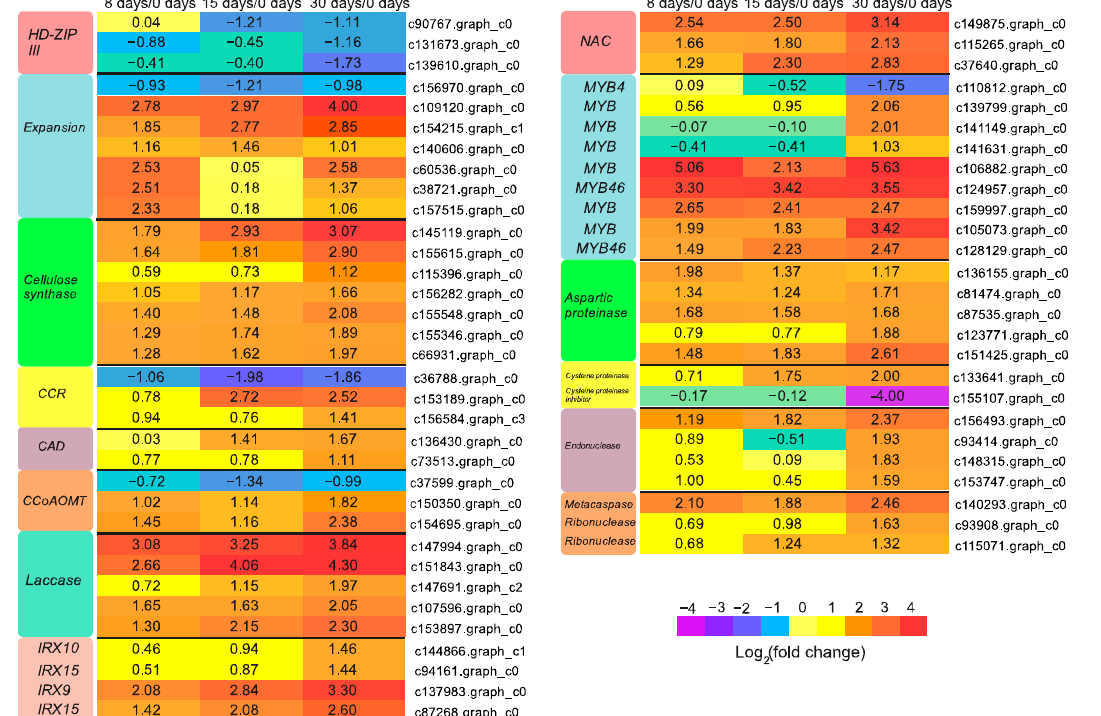
Figure 7. Expression profiles of DEGs involved in vascular bundle formation. Gene expression values were normalized to z-score. The values of log 2 fold change are shown in the heat map.